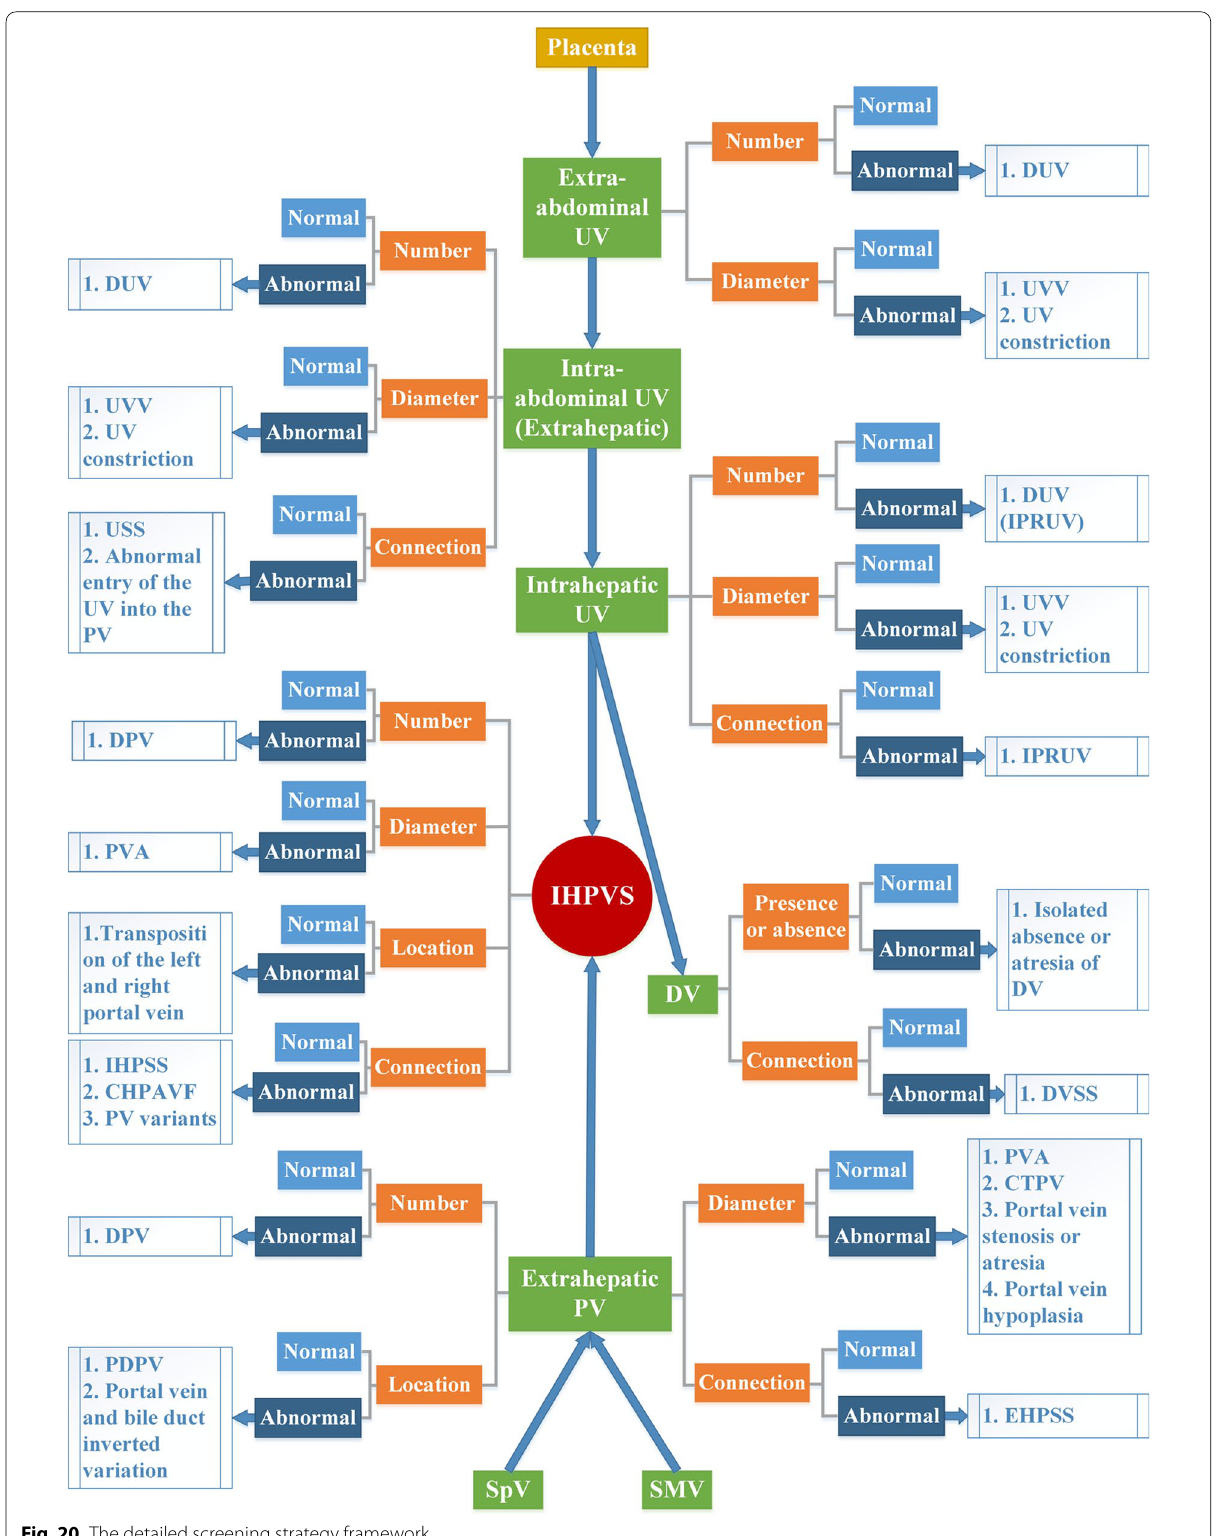
Fig. 20 The detailed screening strategy